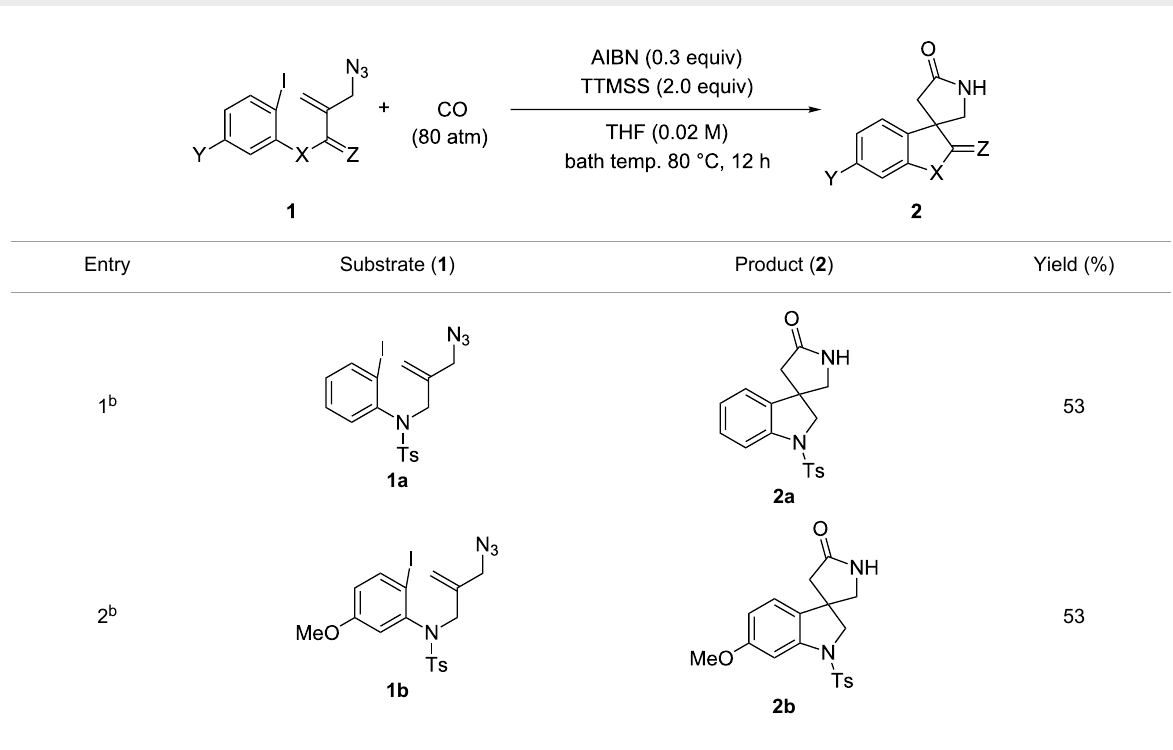
Table 1: Synthesis of 4,4-spirocyclic γ -lactams 2 by tandem radical spirocyclization of 1 with CO.